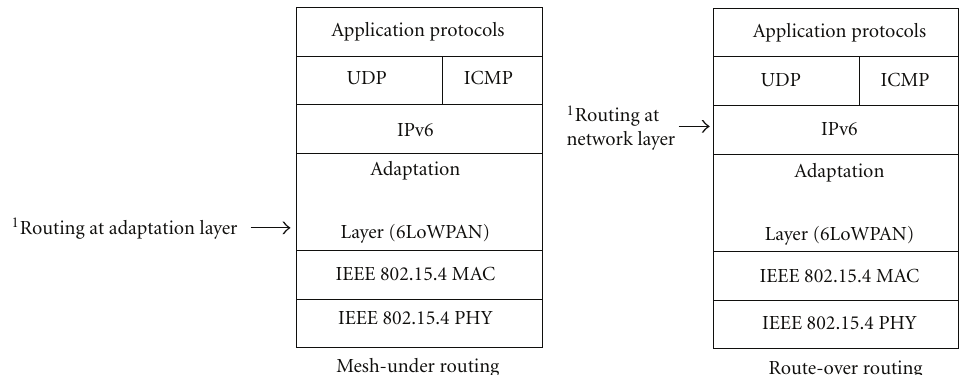
Figure 5: Mesh-under and route-over routing. 1 Routing is not equivalent to IP routing, but includes the functionalities of path computation and forwarding under the IP layer. The term routing is used in the figure in order to illustrate which layer handles path computation and packet forwarding in mesh under compared to route over.